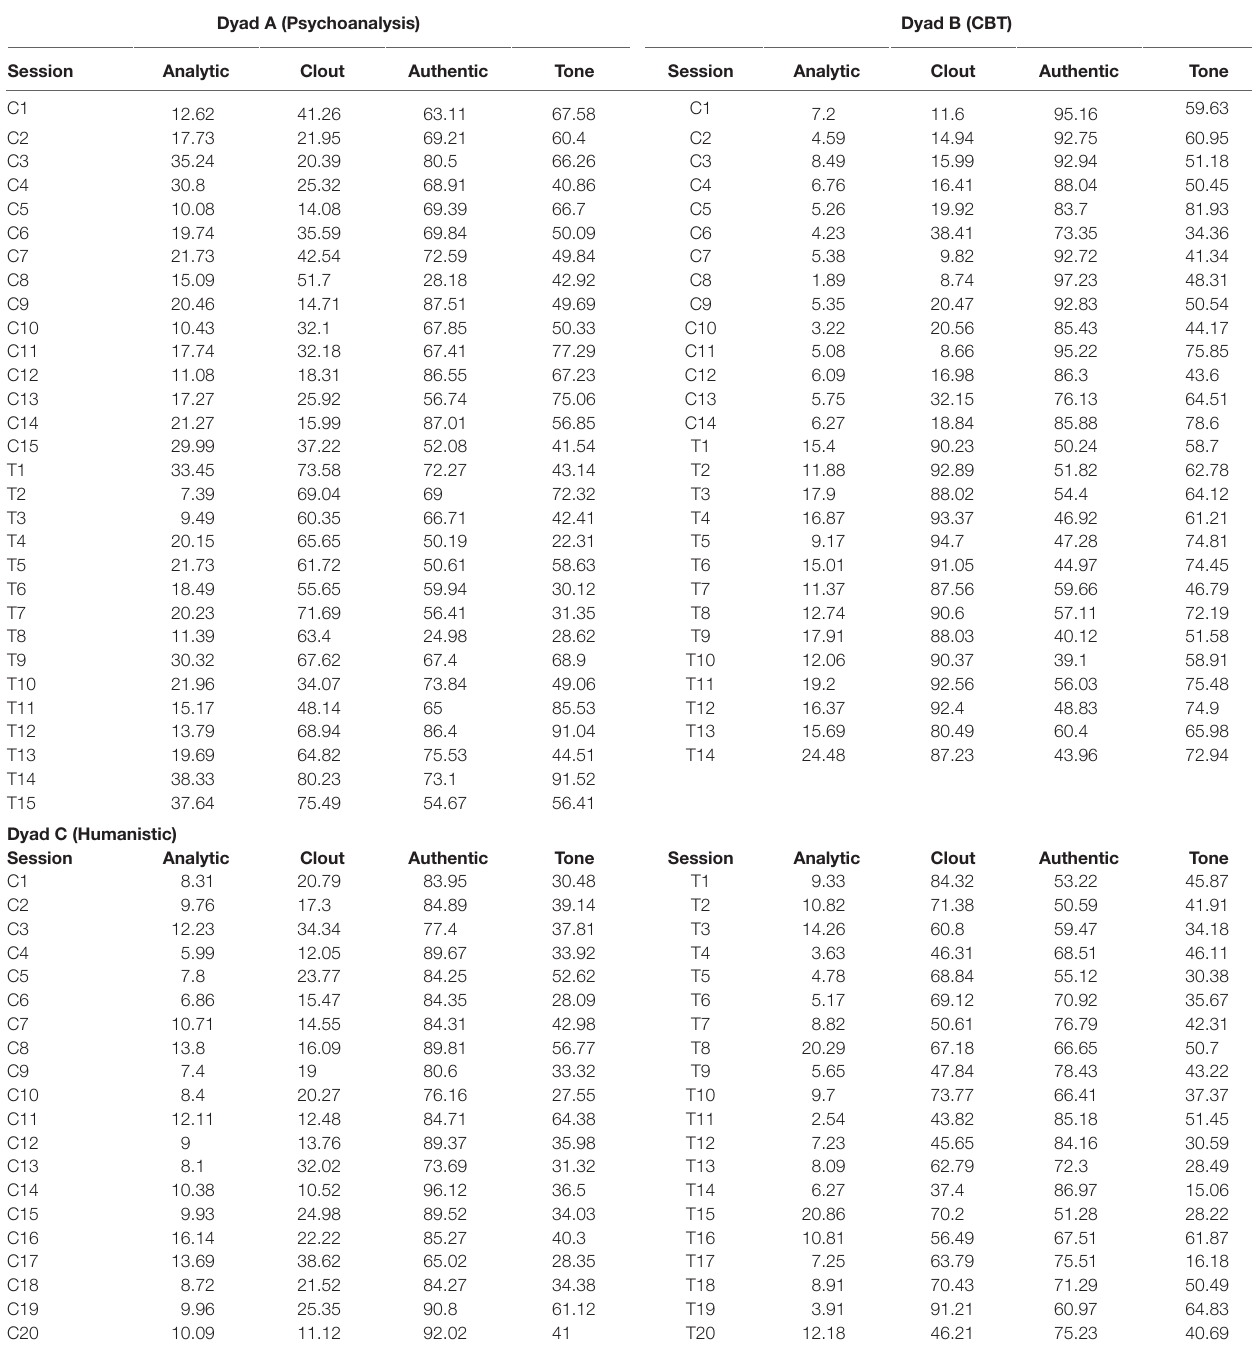
TABLE 2 | Summary variable scores for the three